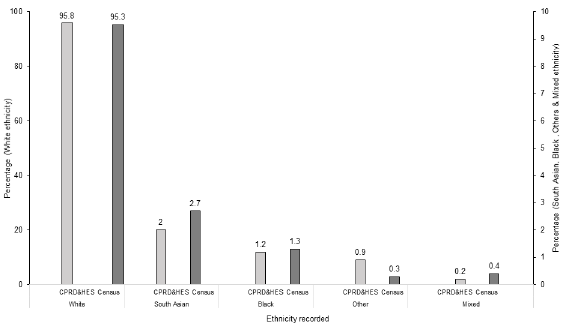
Fig 2. Comparing ethnicity recording (denominator: Those with available data) in electronic health records with English Census 2011. Abbreviations: CPRD ClinicalPractice ResearchDatalinkHES Hospital EpisodeStatistics.